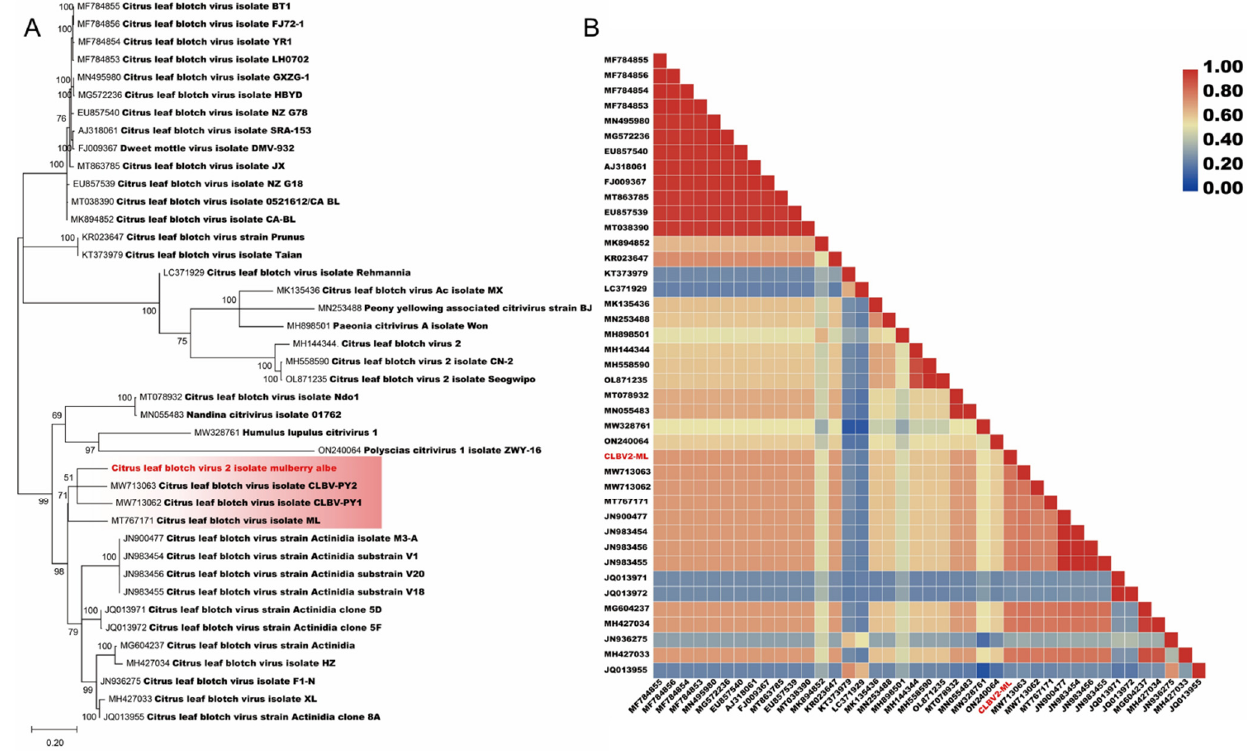
Figure 4. Phylogenetic trees constructed for representative members of the Citrivirus genus. ( A ) The whole sequences for phylogenetic trees. ( B ) The pairwise identity plots of the complete genomic nucleotide sequences aligned by ClustalW and displayed by sequence demarcation using TBtools software. The trees were constructed using the maximum likelihood method, and the statistical significance of the branches was evaluated by bootstrap analysis (1000 replicates). Newly discovered viruses are marked in red; relationship: pink background. Table 2. Sequence similarities of CLBV-ML2 compared to Citrus leaf blotch virus (CLBV) isolates and unassigned citriviruses.